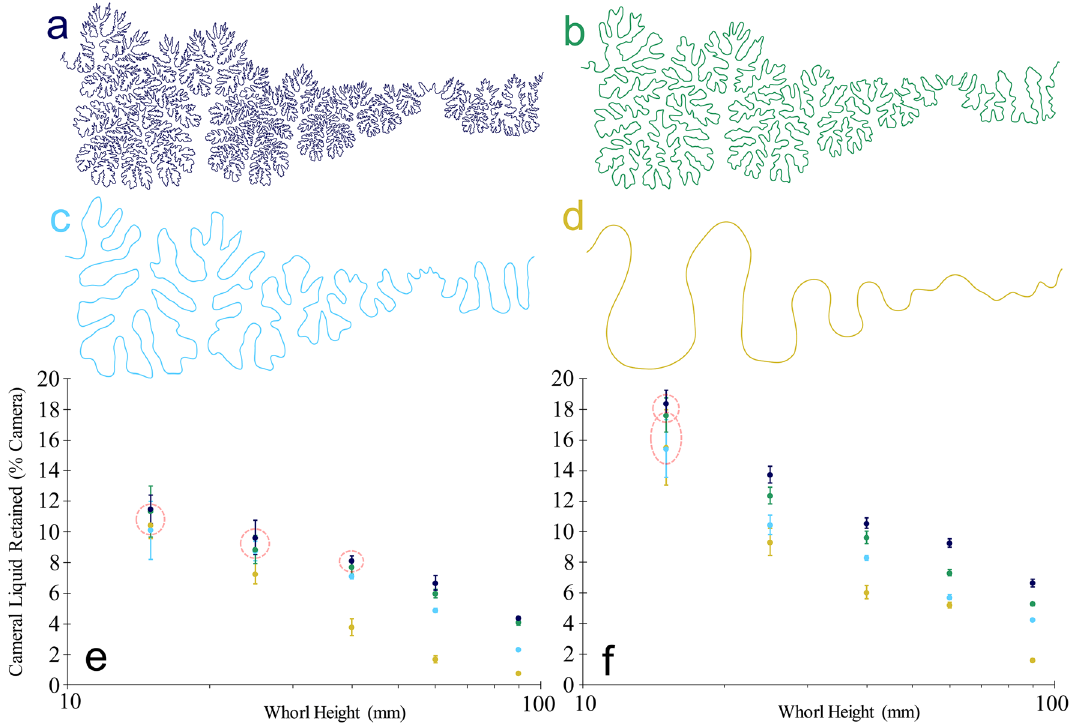
Figure 5. Liquid retention within the 3D printed chamber models of Menuites oralensis . The original suture pattern ( a ) was smoothed to successively remove higher order folds ( b – d ). Only the left hemisutures of the septa are shown. ( e ) Cameral liquid retention (average percent camera at various scales) in the Menuites models with no internal coating. ( f ) Cameral liquid retention in the Menuites models with hydrophilic coating. Whorl heights are dorsoventral lengths measured in the center of the camerae. All data points are color-coded according to the sutures in parts ( a – d ). Error bars represent one standard deviation (n = 10). Red dashed circles highlight data pairs that cannot be statistically distinguished with a Games-Howell post hoc test (p >